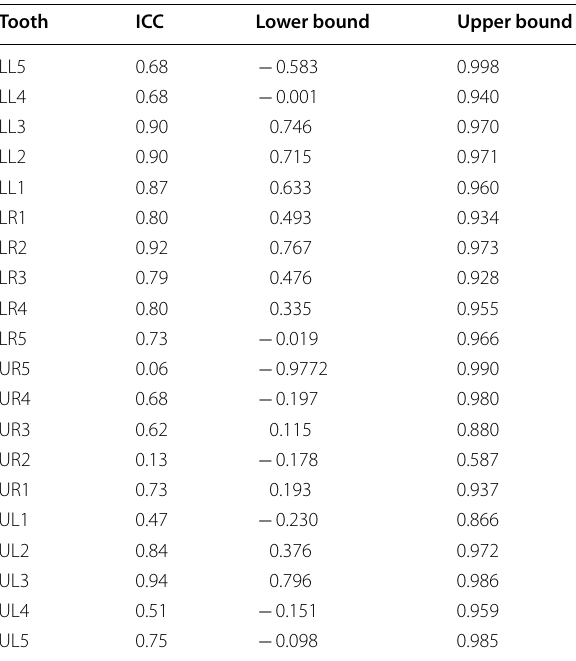
Table 3 Intraclass correlation coefficient to assess interexaminer